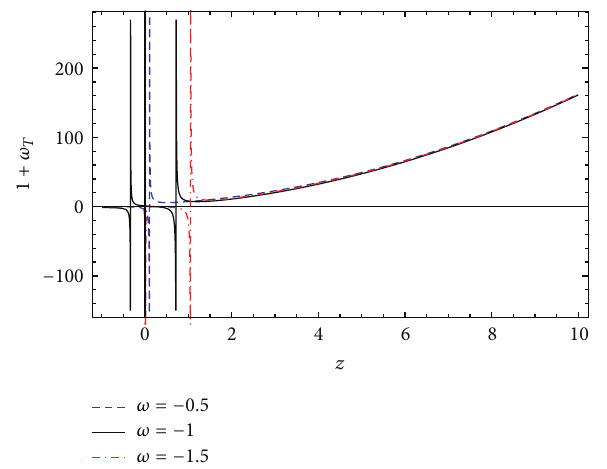
Figure 9: Evolution of 1 + 𝜔 𝑇 reconstructed 𝑓(𝑇) in quintessence model for Ω 𝑚0 = 0.315 and 𝐻 0 = 67.3 .